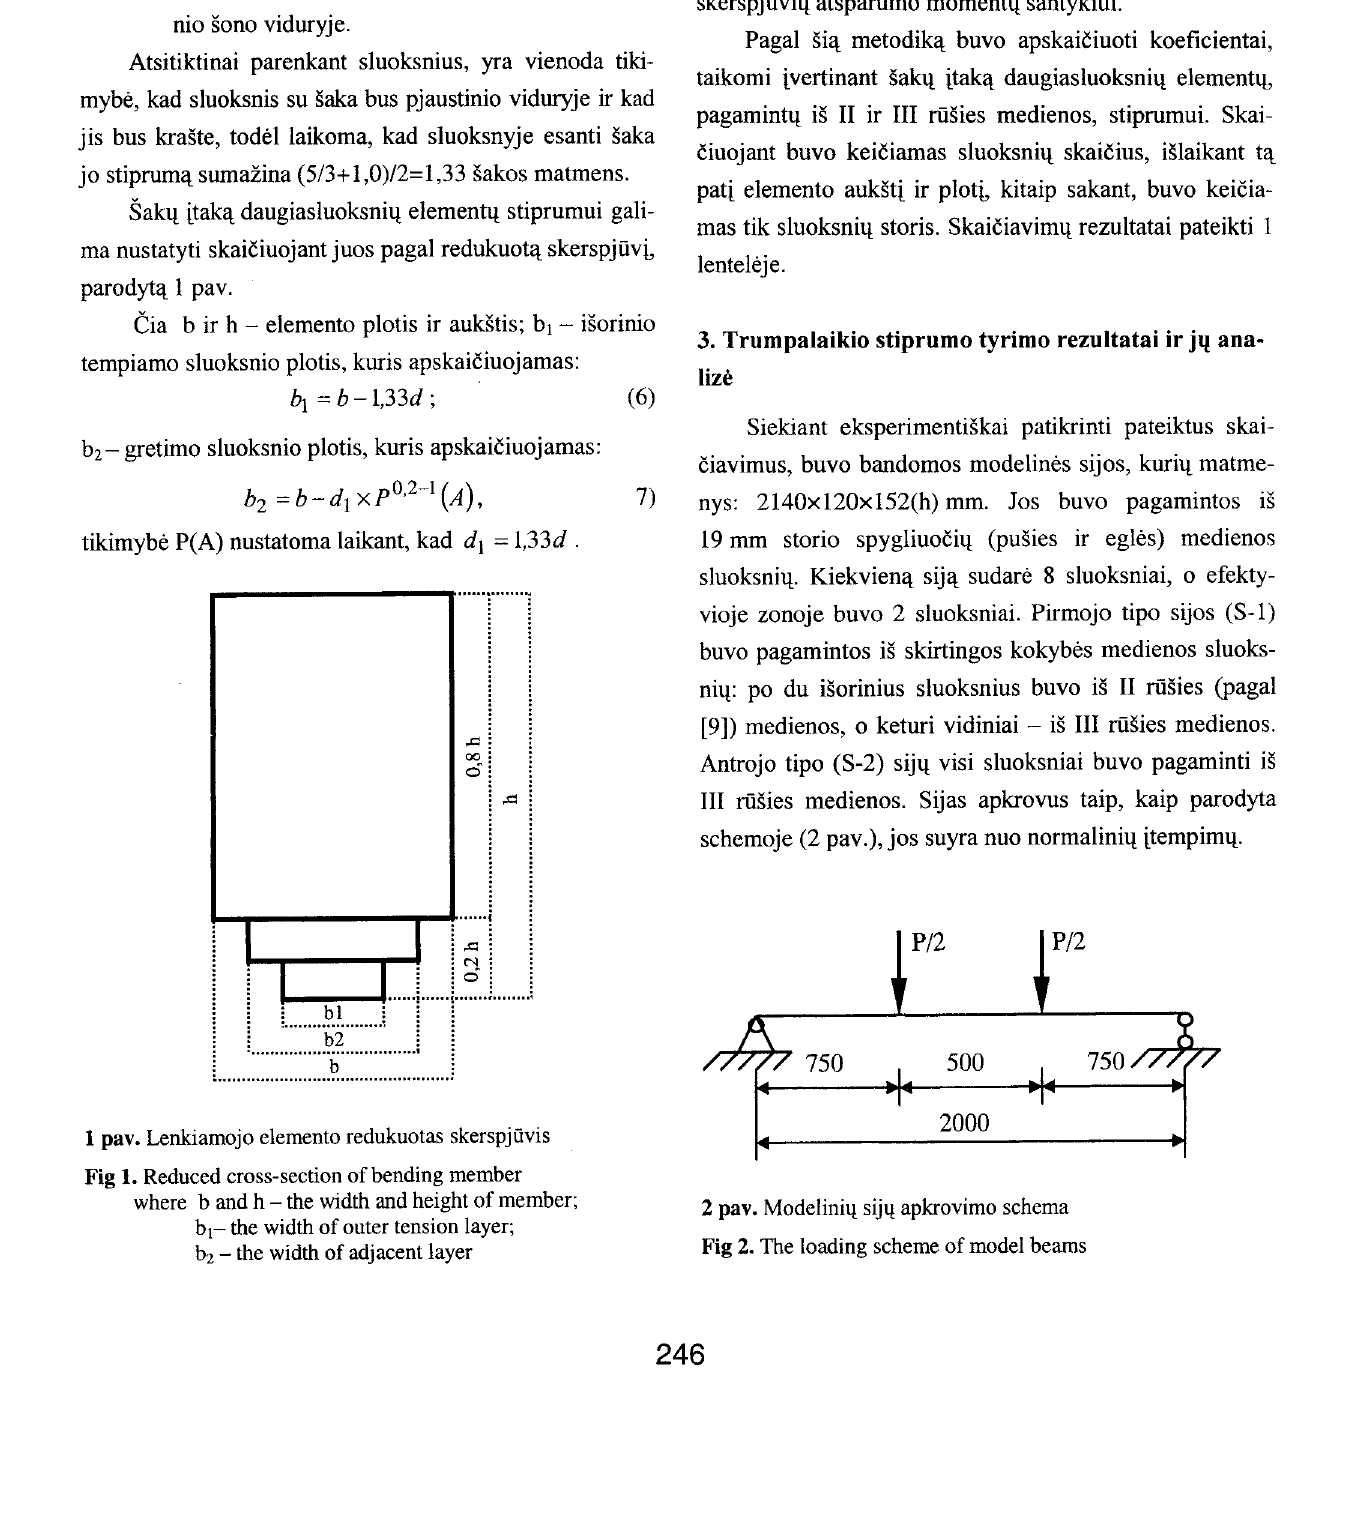
Fig 2. The loading scheme of model beams